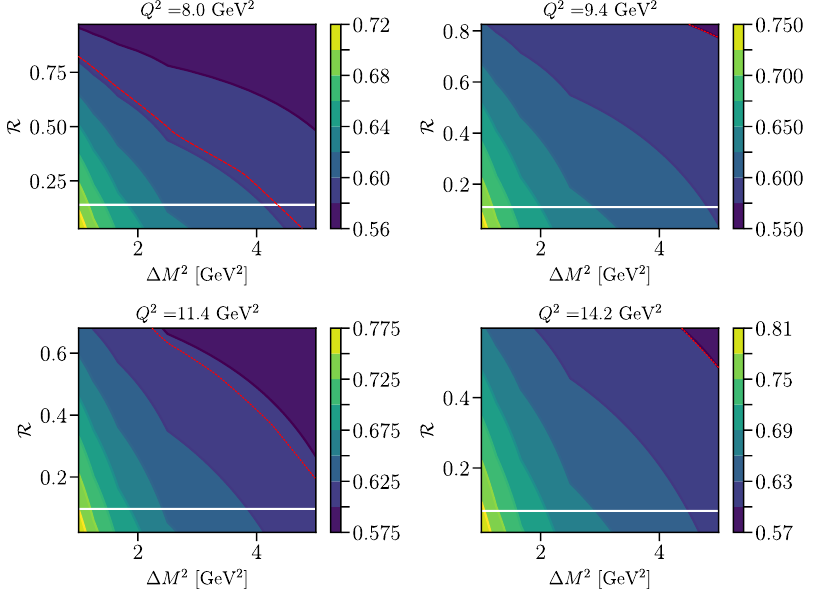
Figure 3. Transparencies resulting from RMSGA calculations with CT effects included in the quantum diffusion model. The dependence on the ∆ M 2 parameter ( x -axis) and ratio R = σ eff ( z = 0 ) / σ tot at the interaction point ( y -axis) is shown. The four panels show the four measured Q 2 bins of the recent JLab experiment. Red dashed lines on the plots delineate the region (above the red line) compatible with the recent JLab data [9] at the one standard deviation level. White horizontal lines denote the R ( α = 1 ) standard value. See text for